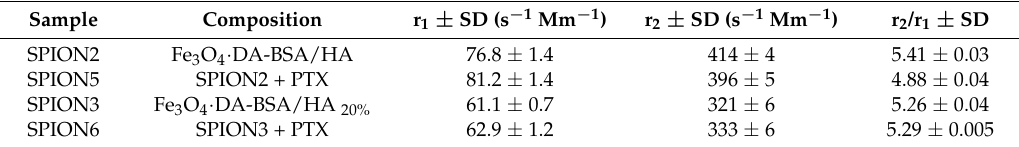
Table 5. Longitudinal relaxation R 1 of SPION2, SPION5, SPION3 and SPION6.